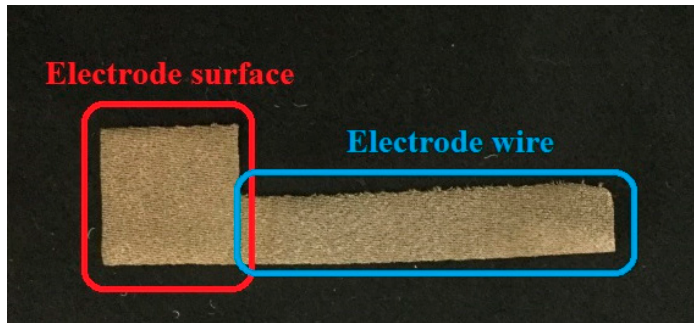
Figure 4. Structure of a textile electrode for the skin-electrode measurement.